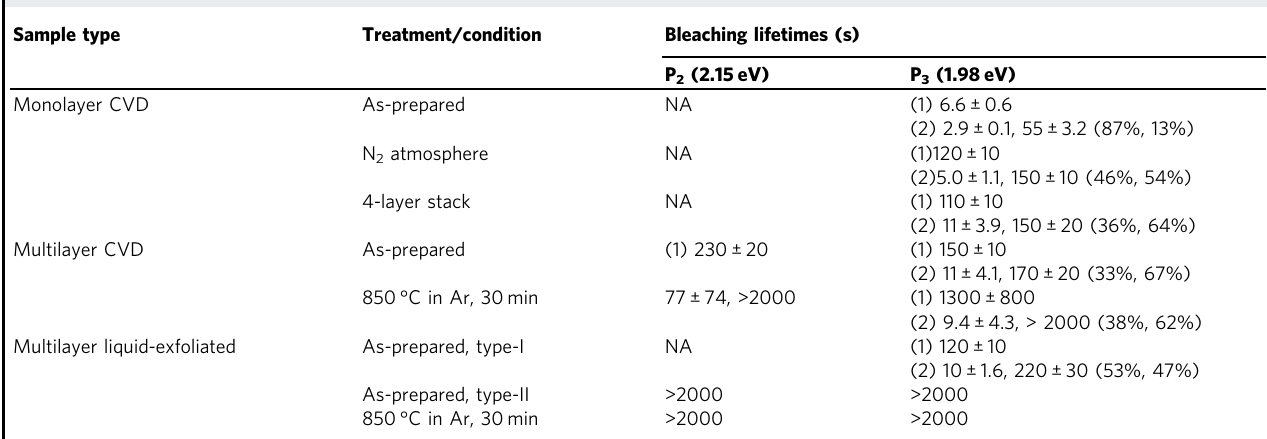
Table 1 Summary of bleaching